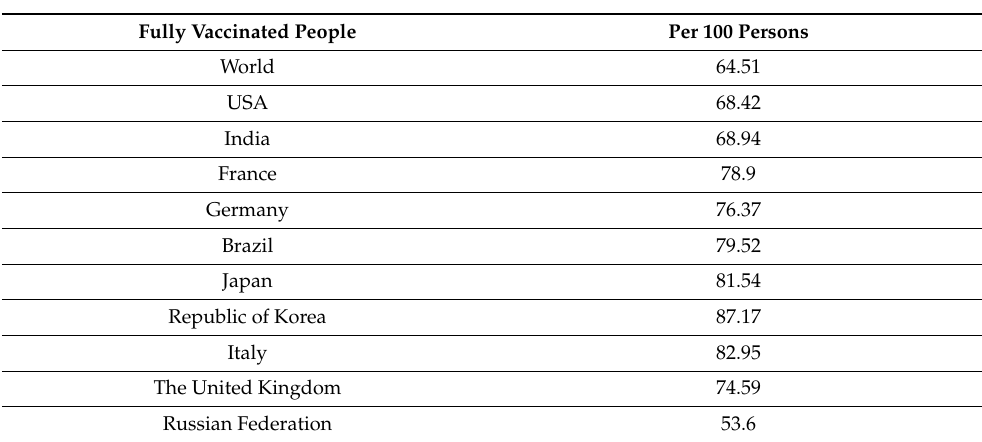
Table 2. COVID-19 Vaccinations status in the global context as per WHO records who have completed their primary vaccination series (https://covid19.who.int/table, accessed on 30 November